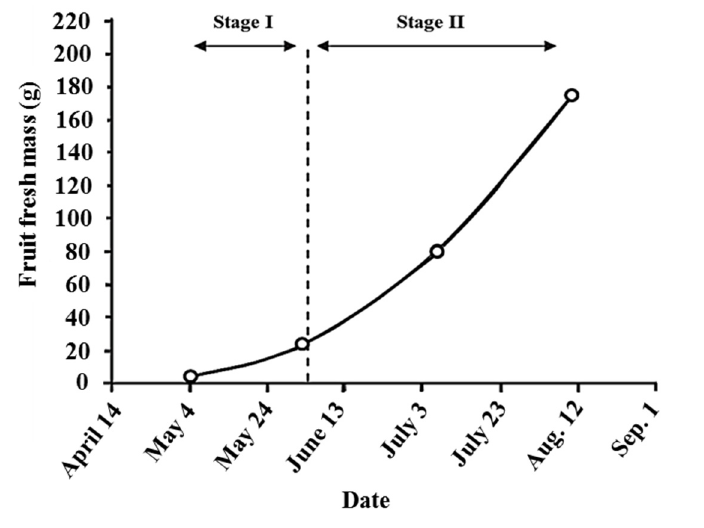
Figure 9. Reproductive growth of pear fruit in Belgium. Adapted from the FAO Crop